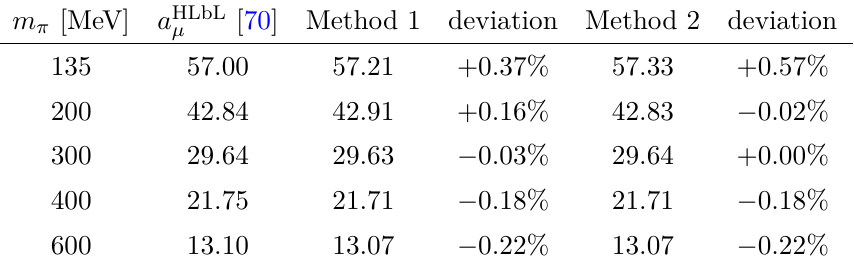
Table 2 . Results for the pion-pole contribution to a HLbL